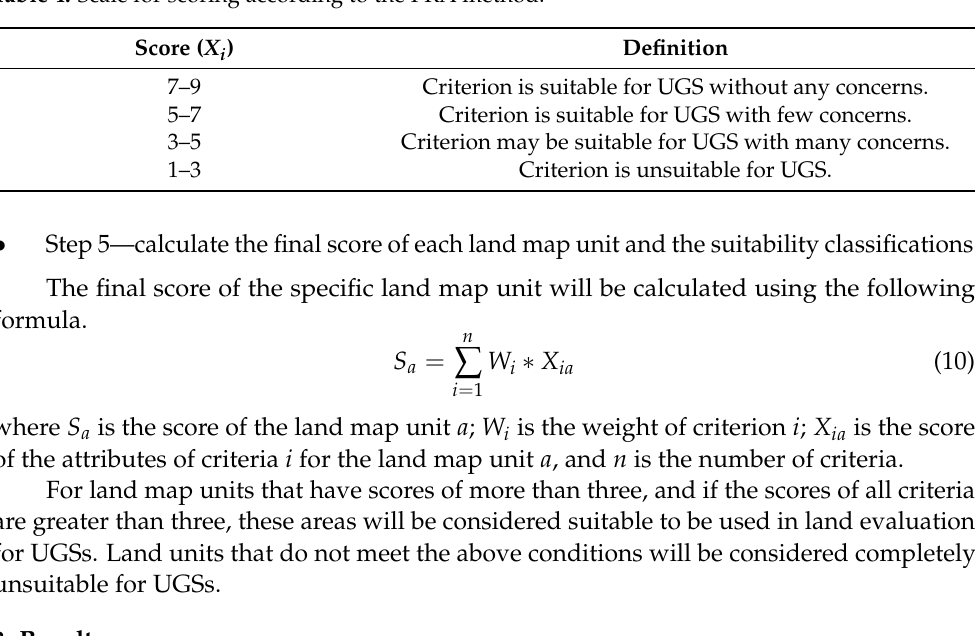
Table 4. Scale for scoring according to the PRA